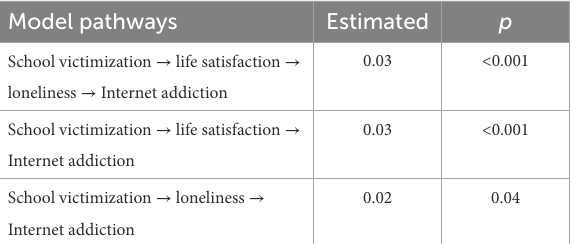
TABLE 2 Standardized indirect effect for the model. Model